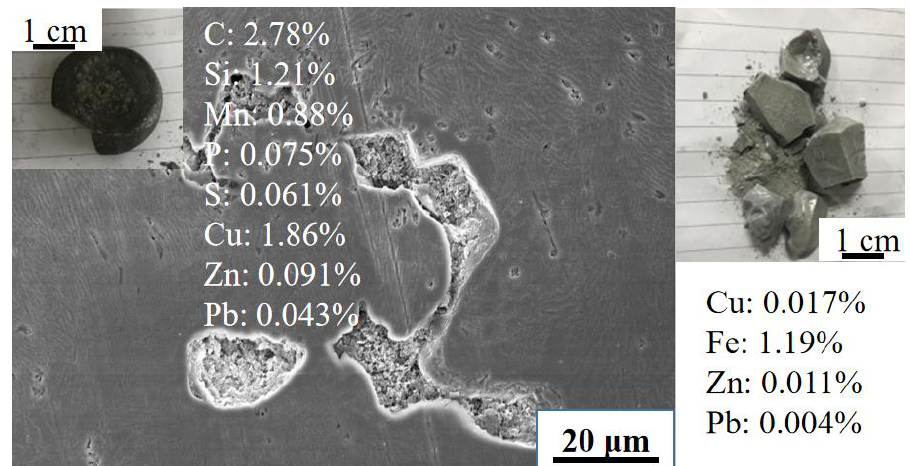
Figure 11. Metal and slag under suitable conditions.